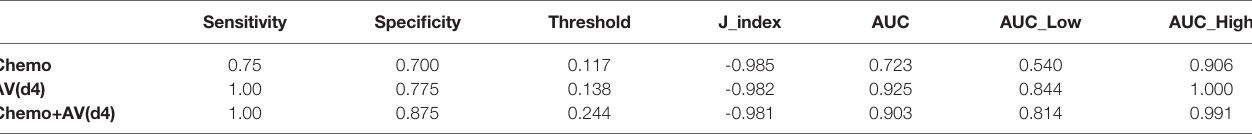
TABLE 2 | Sensitivity, speci fi city, and AUC for the two predictive